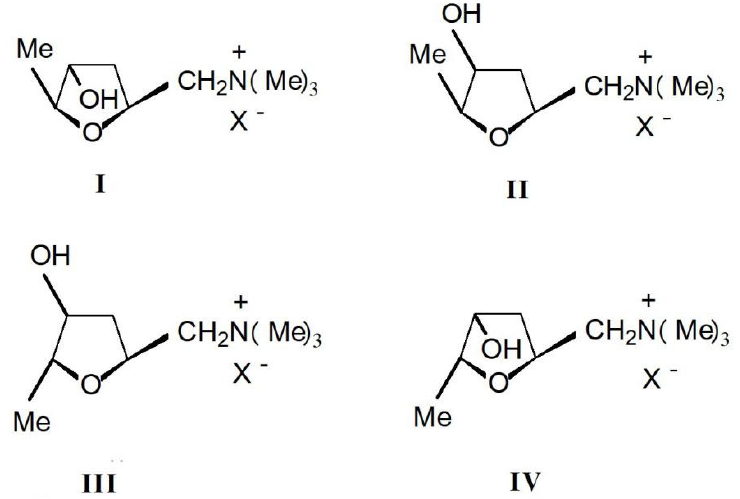
Figure 4. Four stereoisomers of muscarinee: I. muscarine; II.epi-muscarinee; III. allo-muscarinee and IV. epiallo-muscarinee.